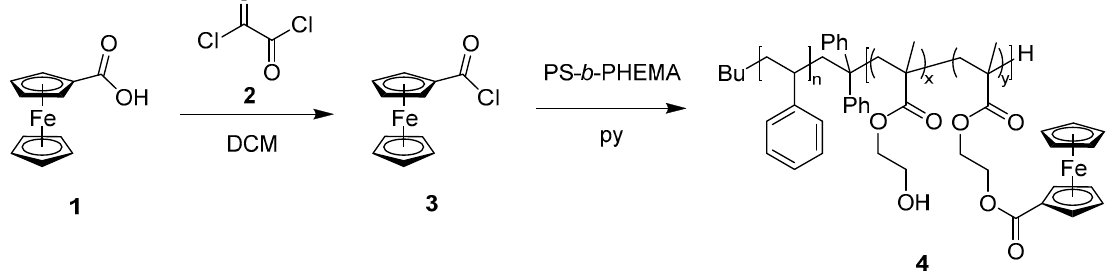
Figure 2. One pot synthesis of the functionalization of PS– b –PHEMA with oxalyl chloride 2 activated